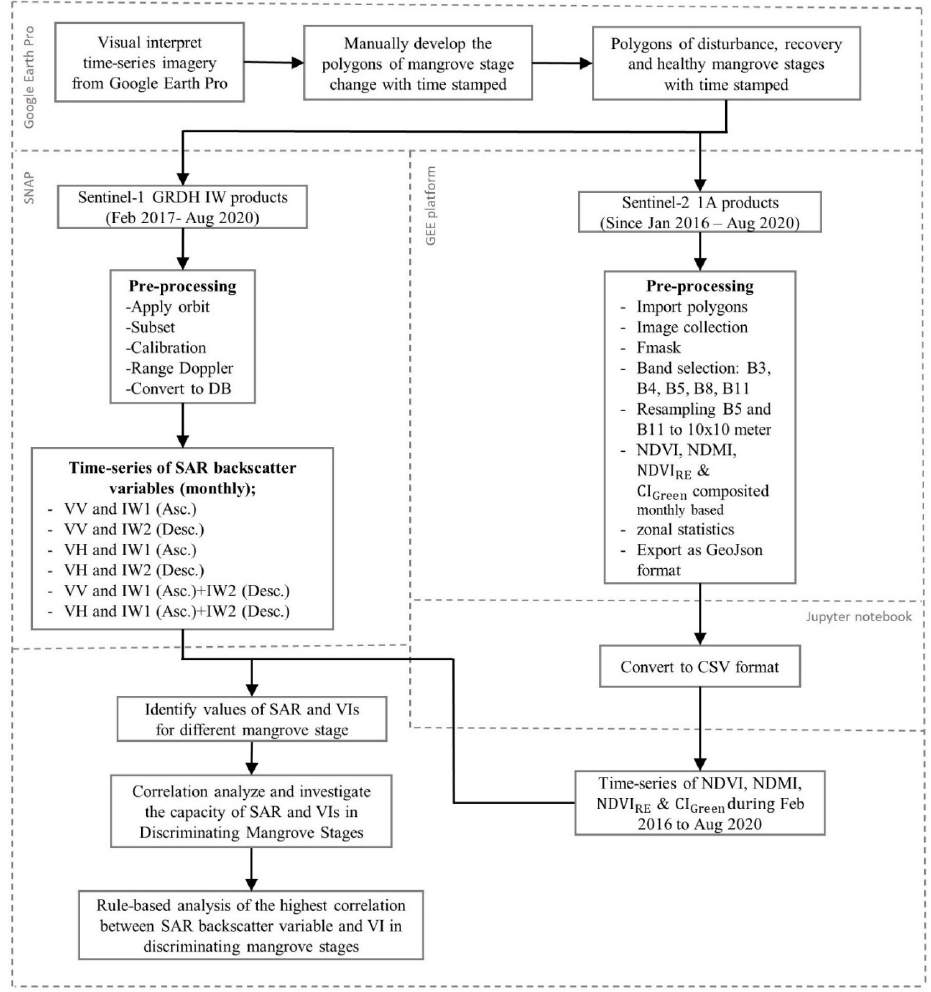
Figure 3. Overall Study Workflow. Figure 3.